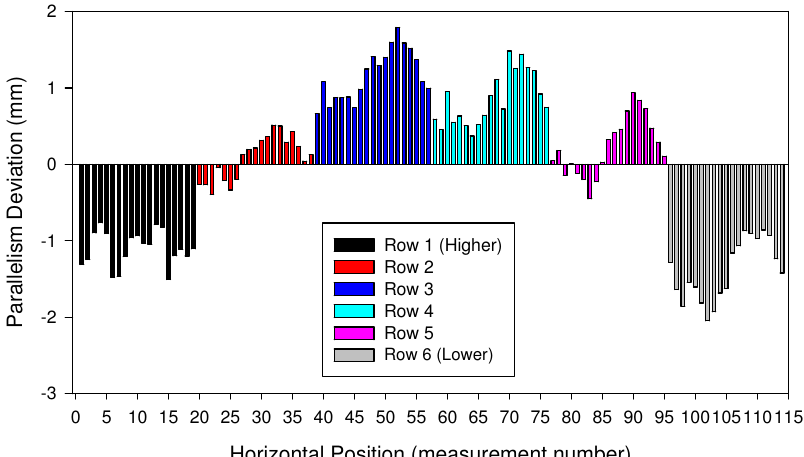
Figure 11. Deviations measured in Box 1 for each row of holes. Average measured distance is taken as the reference (zero value).